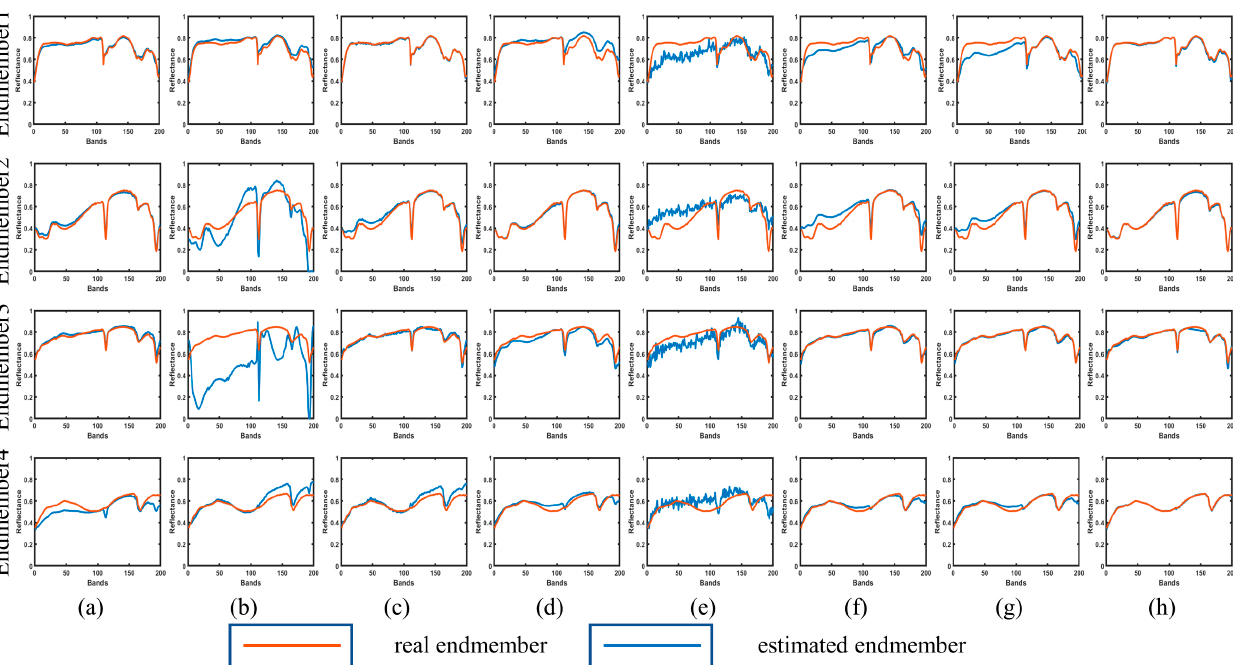
Figure 9. Visualization results of the abundances of the synthetic data (SNR 40 dB). ( a ) VCA-FCLS. ( b ) SGCNMF. ( c ) DAEU. ( d ) MTAEU. ( e ) CNNAEU. ( f ) CyCU-Net. ( g ) MiSiCNet. ( h ) SSANet. ( i ) Ground truth (GT).